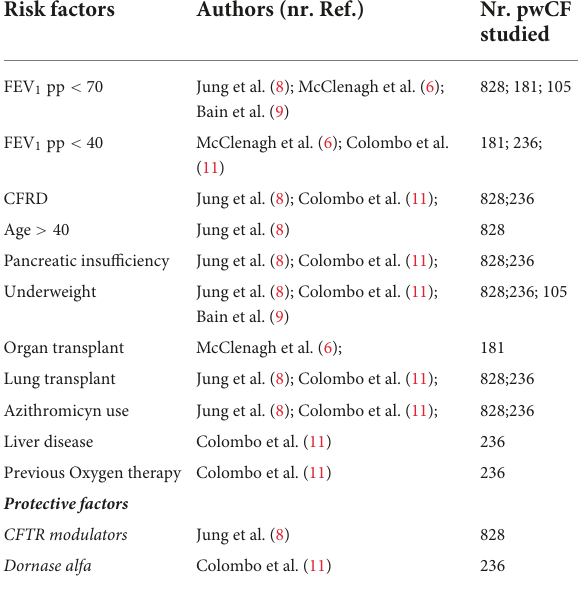
TABLE 1 Risk and protective factors for Hospital admission in COVID-19 pwCF. Risk